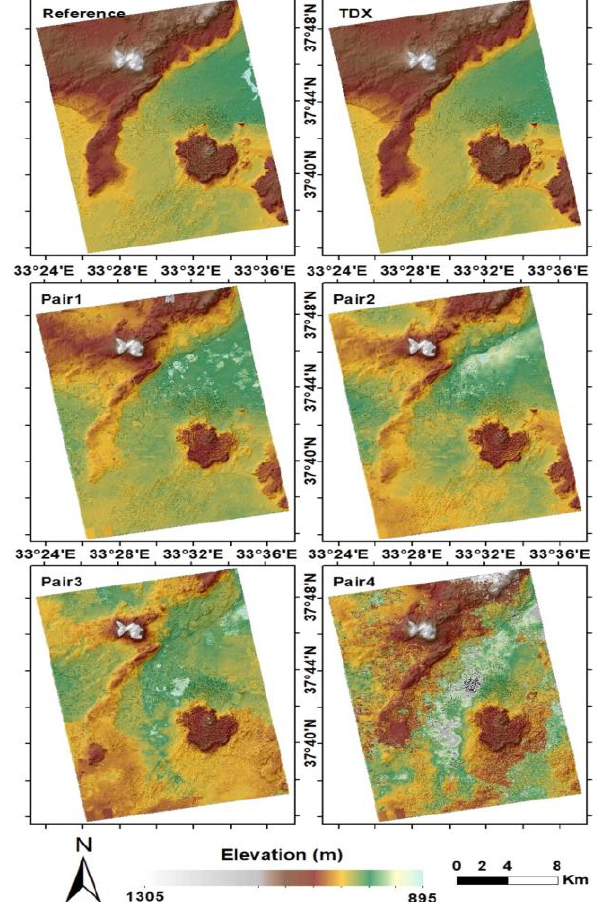
Figure 5. Reference and produced DEMs (PAZ satellite image © Hisdesat Servicios Estratégicos S.A.,